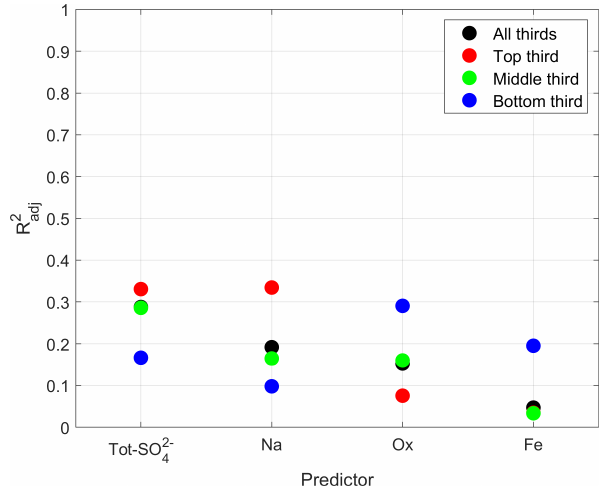
Figure 8. Effect of the influence of normalized cloud height on the ability of a single species to predict N d . For Fe, the top third of cloud (red) data point overlaps with the middle and bottom thirds of cloud (green and blue) data